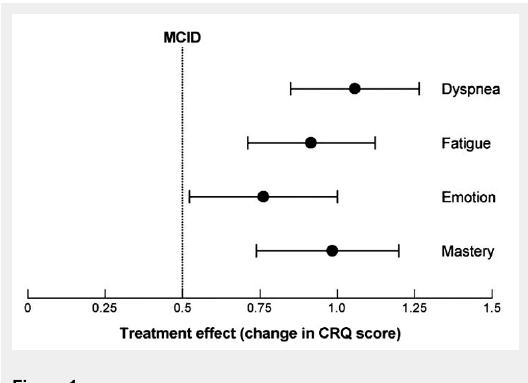
Effects of pulmonary rehabilitation in patients with COPD